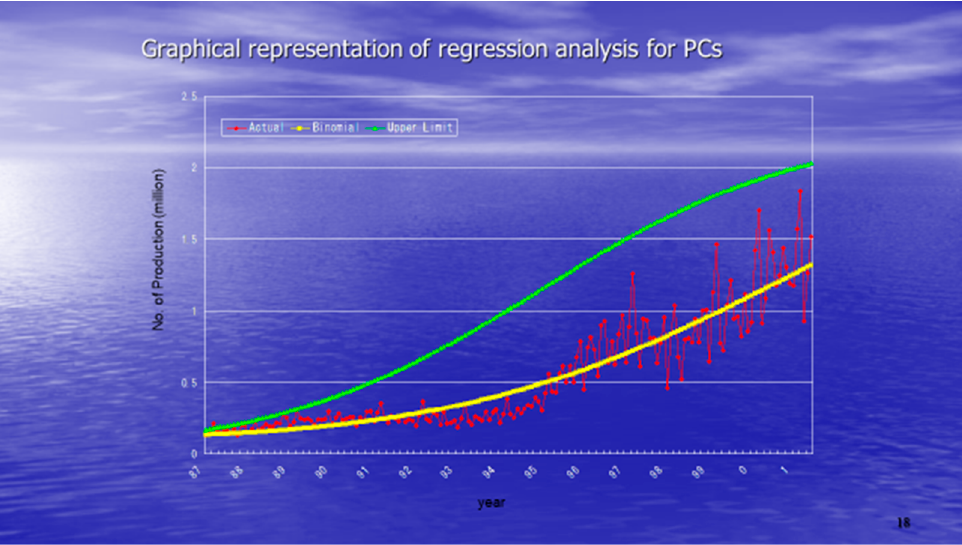
Figure 10. Graphical representation of regression analysis for PCs. Source: Osaki et al. (2001) [26].